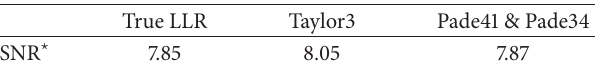
Table 4: Comparison between the iterative threshold of C ∞ (𝑥 2 , 𝑥 3 ) LDPC code ensembles using different LLR calculation methods on